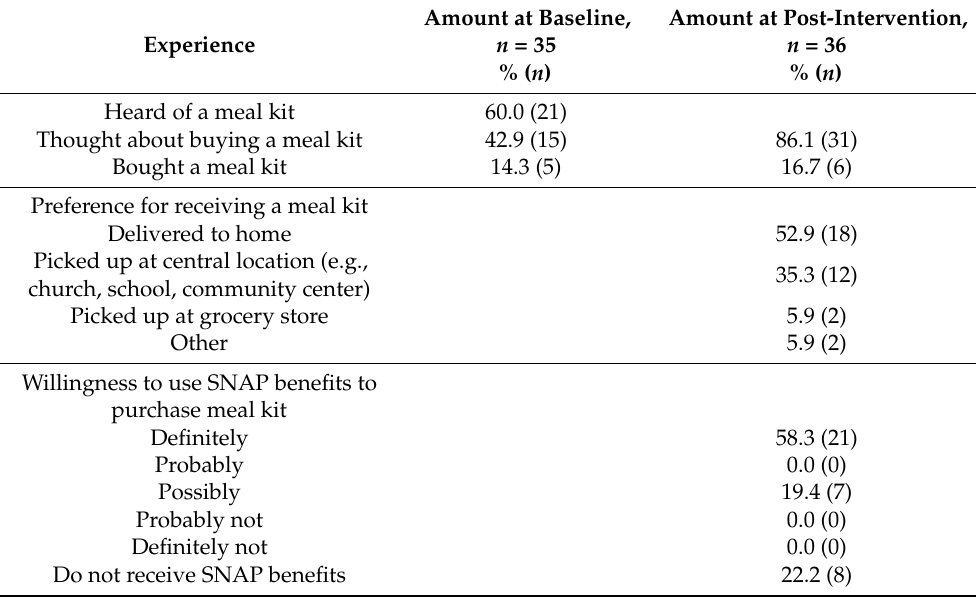
Table 2. Participant Experience with and Preferences for Meal